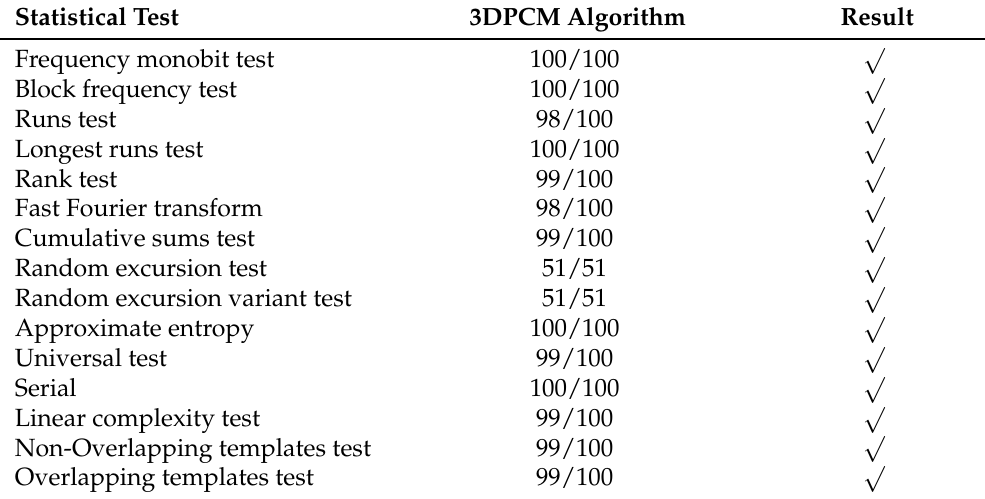
Table 11. NIST statistical test for 100 enciphered images via the 3DPCM algorithm at c 0 = 1,